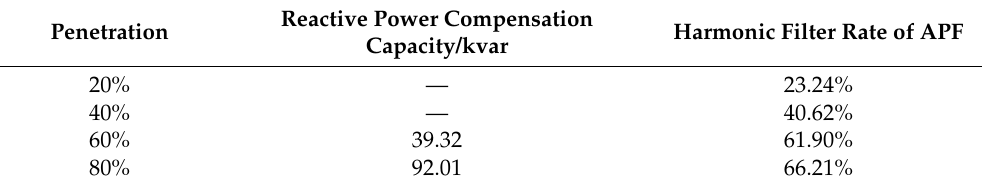
Table 2. Reactive power compensation capacity and APF capacity configuration